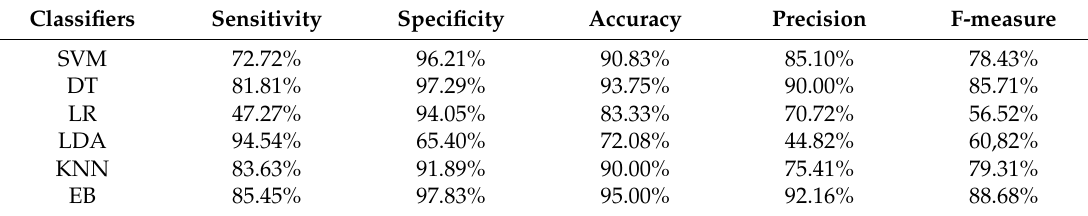
Table 4. Classification results based on genetic algorithm coupling with different classifiers.